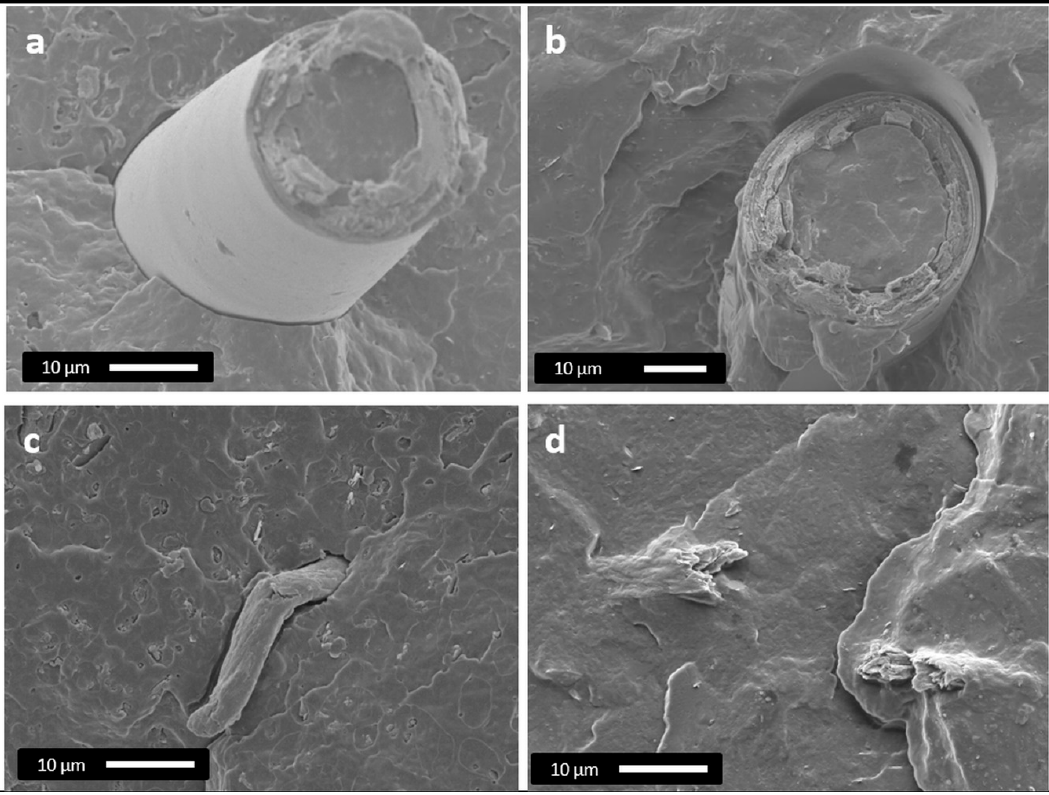
Figure 6. ( a ) SEM micrographs of PHB/U_RH, ( b ) PHB/U_RH/HMDI, ( c ) PHB/T_RH, and ( d )